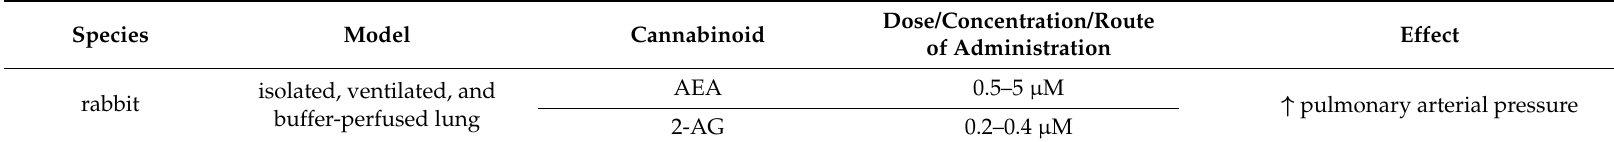
Table 4. Influence of cannabinoids on pulmonary circulation in in vivo or in vitro